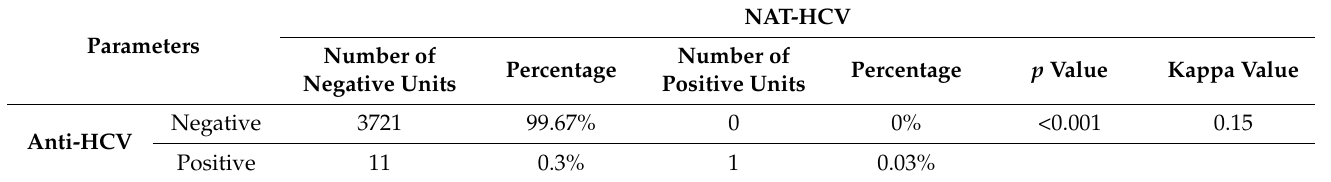
Table 7. Correlation between NAT-HCV and HCV serological